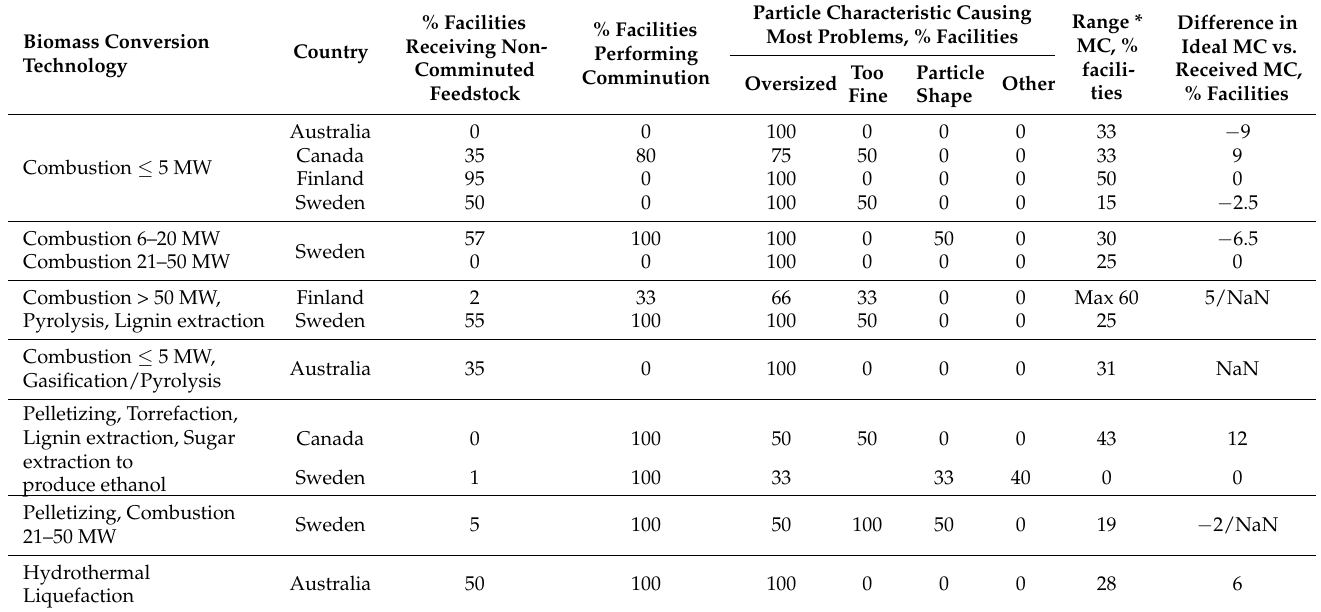
Table 4. The averaged percentage of facilities using a given biomass assortment, by conversion technology and country. MC: moisture content. *: max–min.